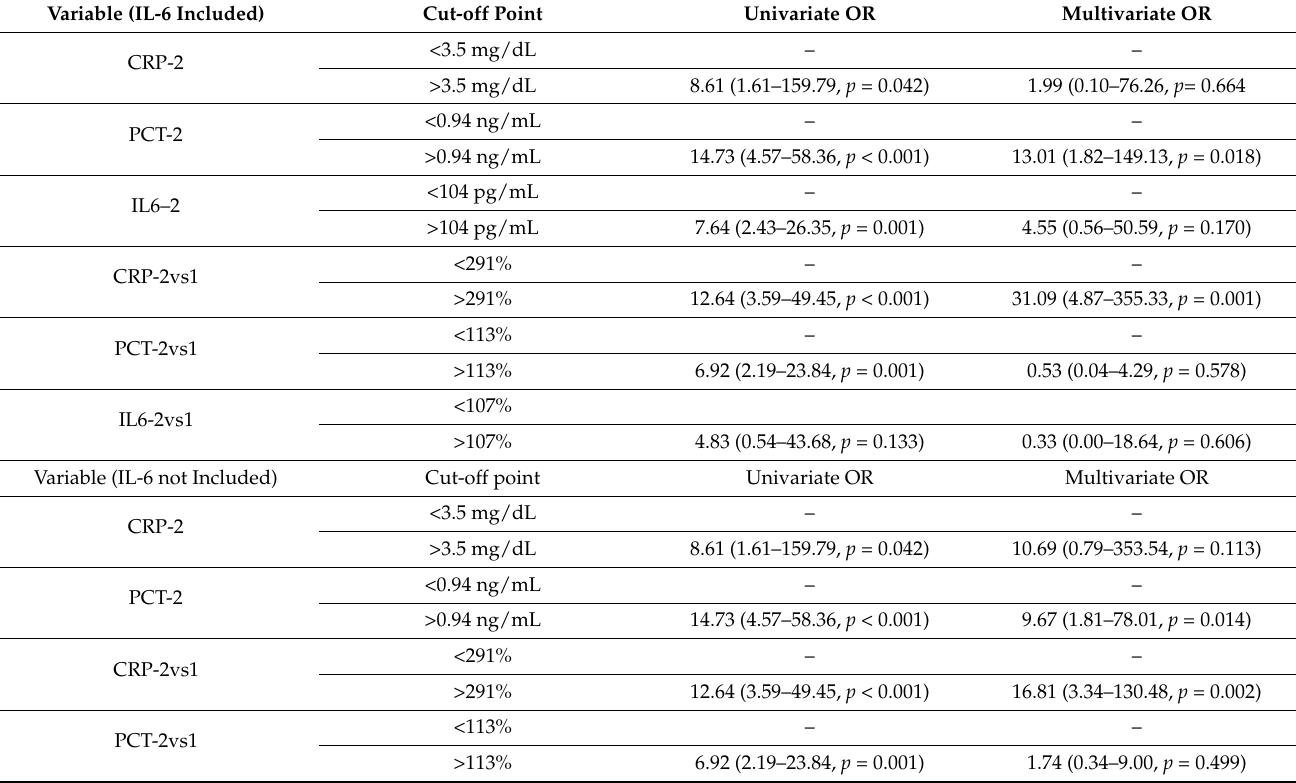
Table 5. Cut-off values and odds ratio (95% confidence interval and p -value) in univariate and multivariate analysis for HRE diagnosis at second (12–24 h) evaluation with or without